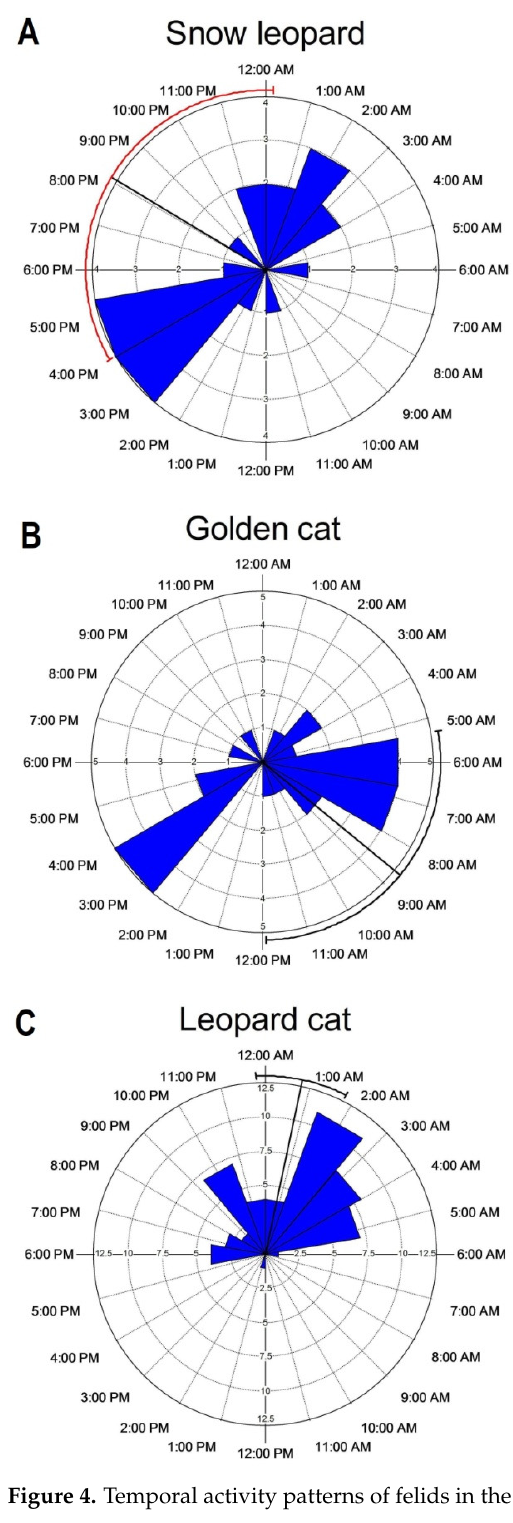
Figure 4. Temporal activity patterns of felids in the Prek catchment of KBR.